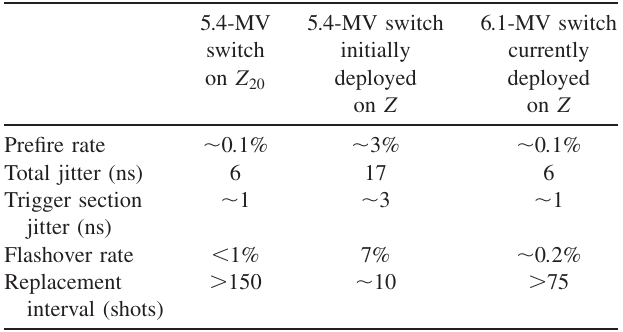
TABLE I. Comparison between the performance of (i) the 5.4- MV laser-triggered gas switch (LTGS) on the engineering test module Z 20 ; (ii) the cumulative performance of 5.4-MV LTGS originally deployed on the Z accelerator; and (iii) the 6.1-MV LTGS utilized presently on Z .